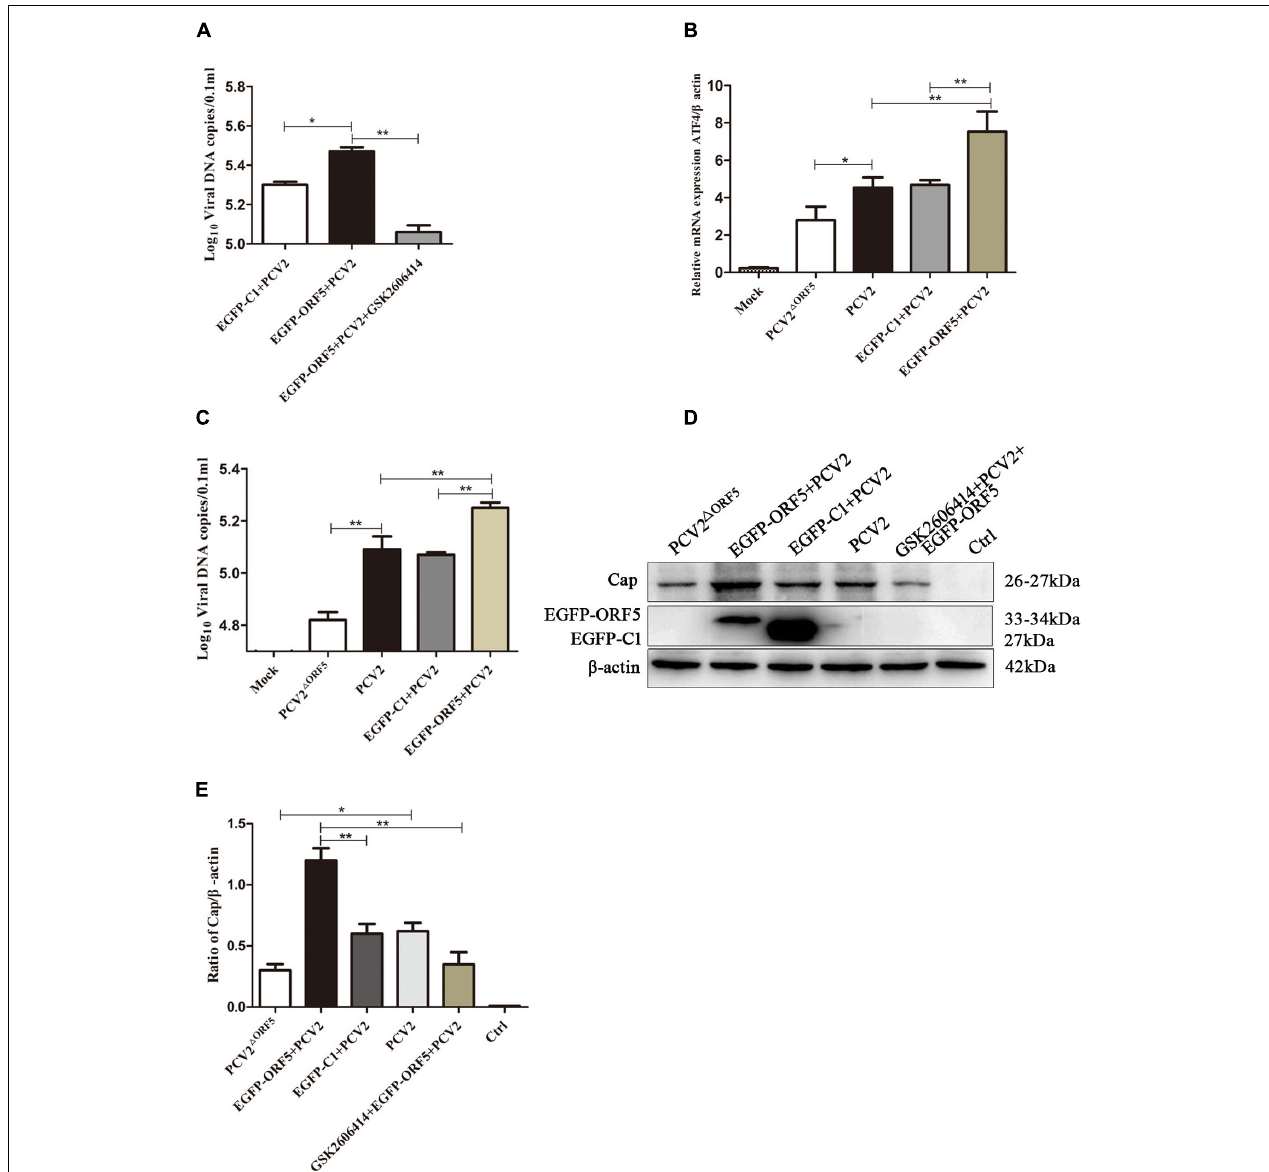
FIGURE 8 | ORF5 protein promotes PCV2 replication by PERK-eIF2 α -ATF4 pathway. (A) PK-15 cells were pretreated with GSK2606414 for 2 h and then transfected with EGFP-ORF5 for 12 h and infected with PCV2 for 36 h. PCV2 DNA copies were quantified by quantitative PCR. (B) PK-15 cells were transfected with EGFP-ORF5 for 12 h and then infected with PCV2 or PCV2 (cid:49) ORF5 for 36 h. The mRNA level of ATF4 was detected by using RT-qPCR. (C) PCV2 DNA copies were quantified by quantitative PCR. (D) PK-15 cells were pretreated with GSK2606414 for 2 h and then transfected with EGFP-ORF5 for 12 h and then infected with PCV2 or PCV2 (cid:49) ORF5 for 36 h. Cap protein and GFP protein were detected by immunoblotting. (E) T -test on the grayscale analysis of the (D) picture, the ratio of Cap to β -actin. * p < 0.05, ** p <